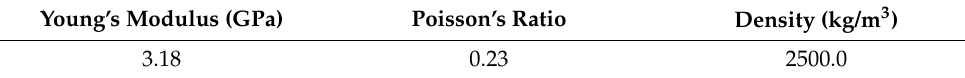
Figure 10. Deba arch bridge: ( a ) site view [17] and ( b ) geometry (unit: m) and FDEM mesh. Table 5. Material properties of Deba arch bridge.